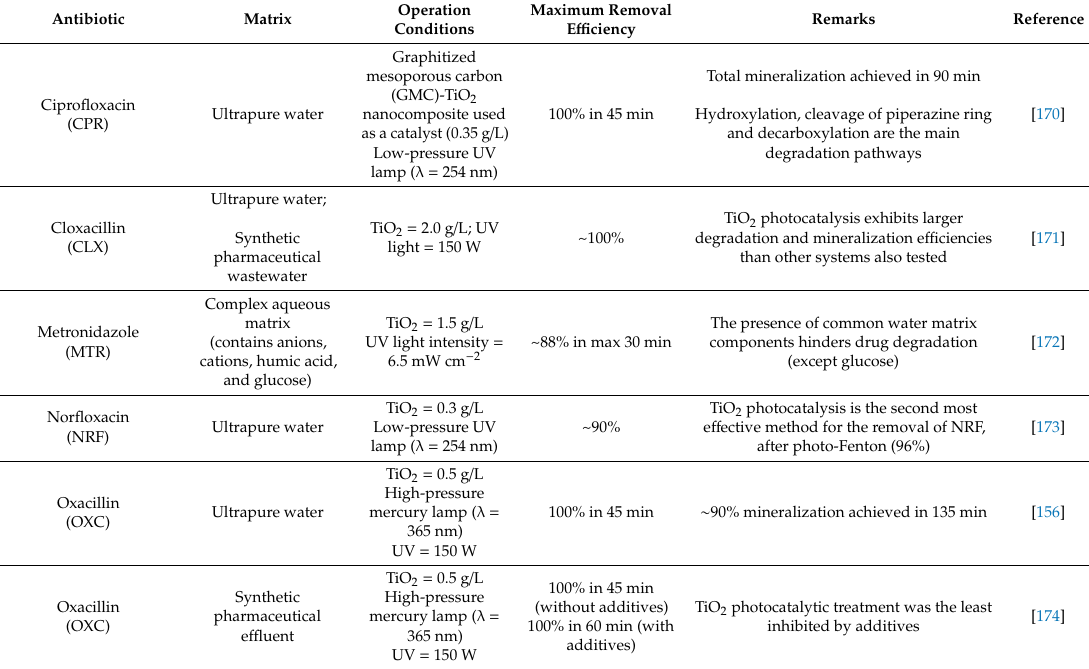
Table 13. Removal e ffi ciency of antibiotics in waters by TiO 2 / UV advanced oxidation